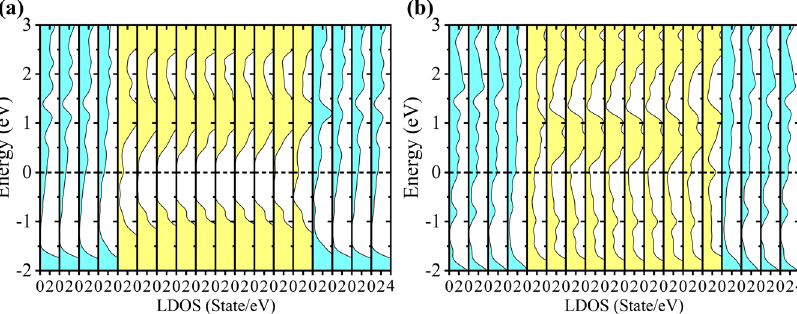
Fig. 5 The layer-resolved density of states of FTJ. Layer-resolved density of states (LDOS) projected on every half orthorhombic cell (including 2 In atoms, 3 Se atoms, 1 Sn atom, and 1 Te atom) of the IP FTJ along the transmission direction for a P ↓ states, b P ↑ states. LDOS of the In 2 Se 3 /SnTe barrier layers and (In 0.5 Sn 0.5 ) 2 Se 3 /(Sn 0.5 Sb 0.5 )Te electrodes are plotted in yellow and blue,